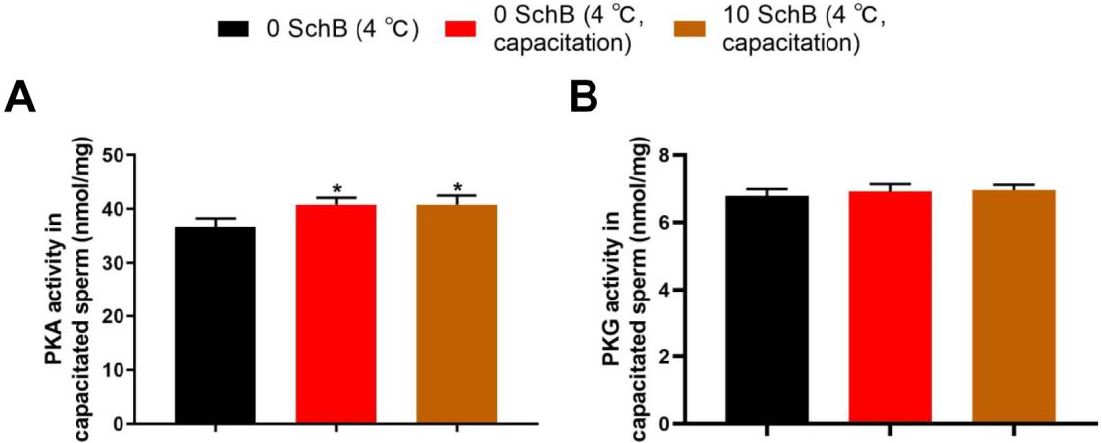
Figure 11. Effects of Sch B on PKA ( A ) and PKG Levels ( B ) in capacitated boar sperm: Data are ± SD ( n = 12). * p < 0.05 vs. 0 Sch expressed as mean ± SD ( n = 12). * p < 0.05 vs. 0 Sch B. expressed as mean